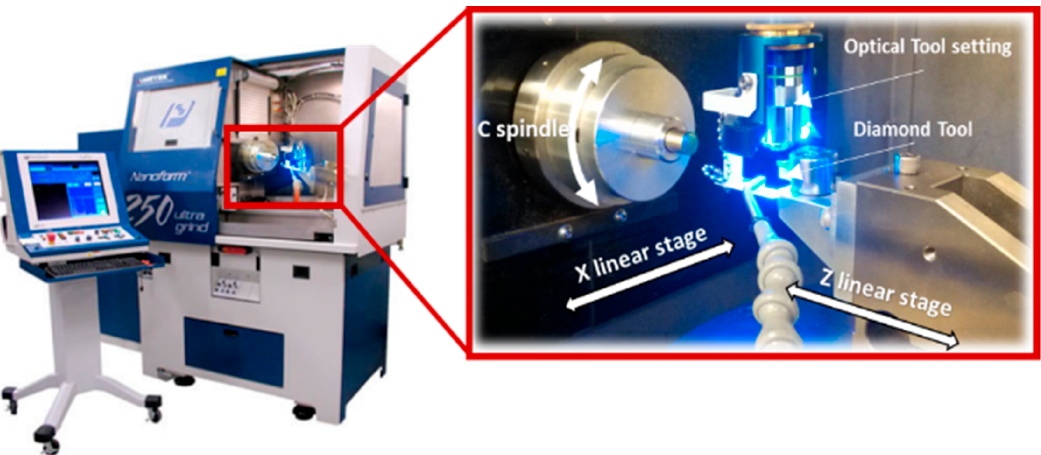
Figure 17. Experimental setup of STS machining.